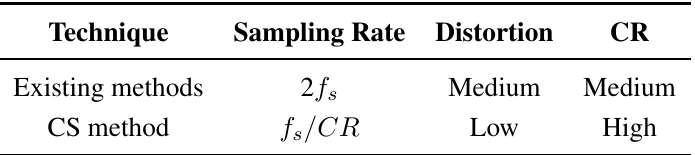
Table 1. Compression